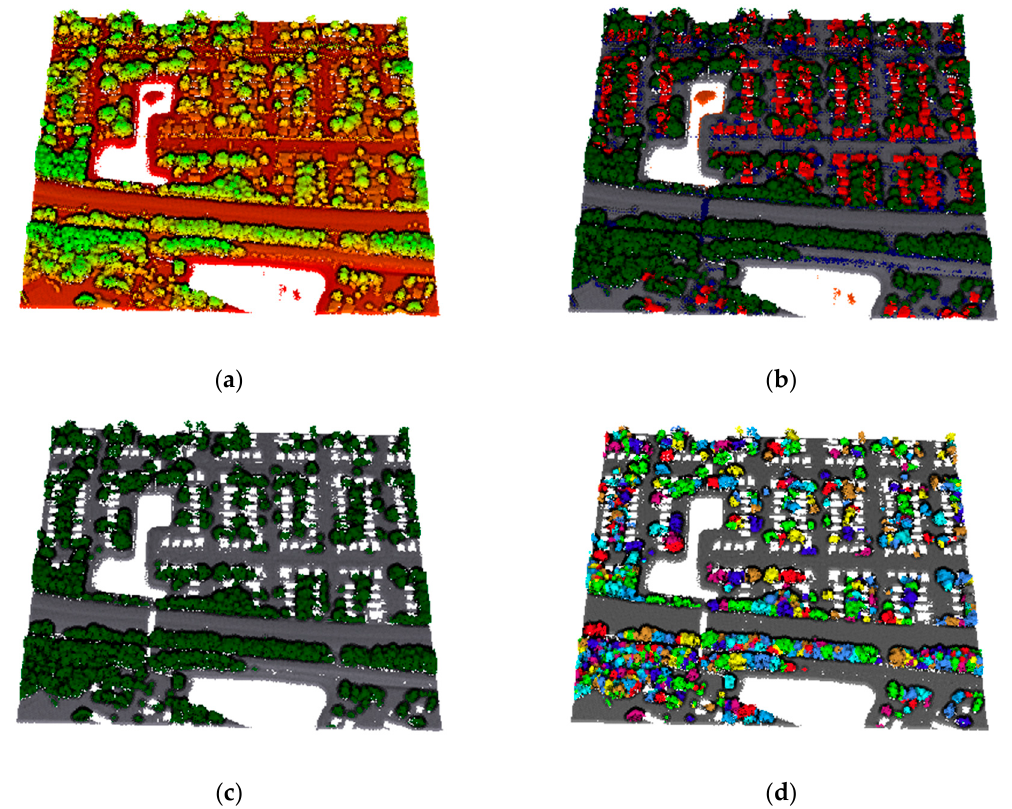
Figure 12. Detailed results from selected area 2 of DFC 3D dataset. ( a ) the original point clouds; ( b ) the classification result; ( c ) the roadside trees extraction; ( d ) the roadside trees segmentation.